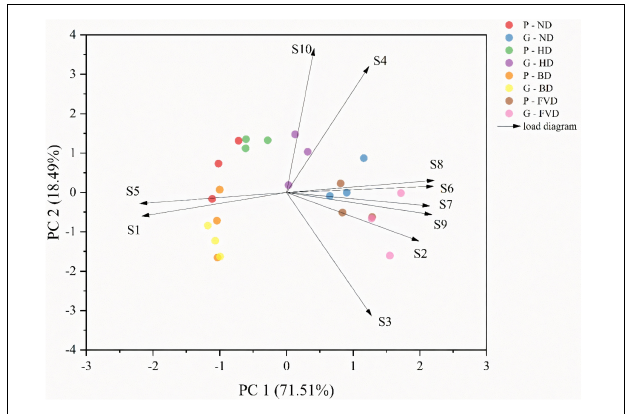
FIGURE 4 | The analysis of principal component scores of different drying methods for the quality of asparagus samples.